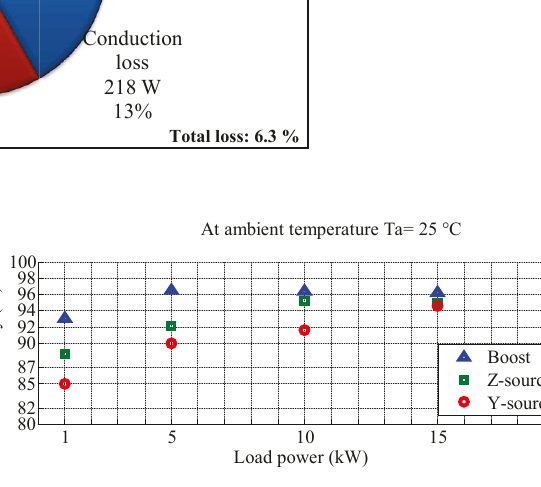
Fig. 9. The efficiency at different loading power and using a volatge gain of 4.